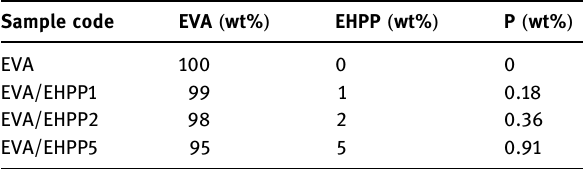
Table 1: Formulas of EVA samples Sample code